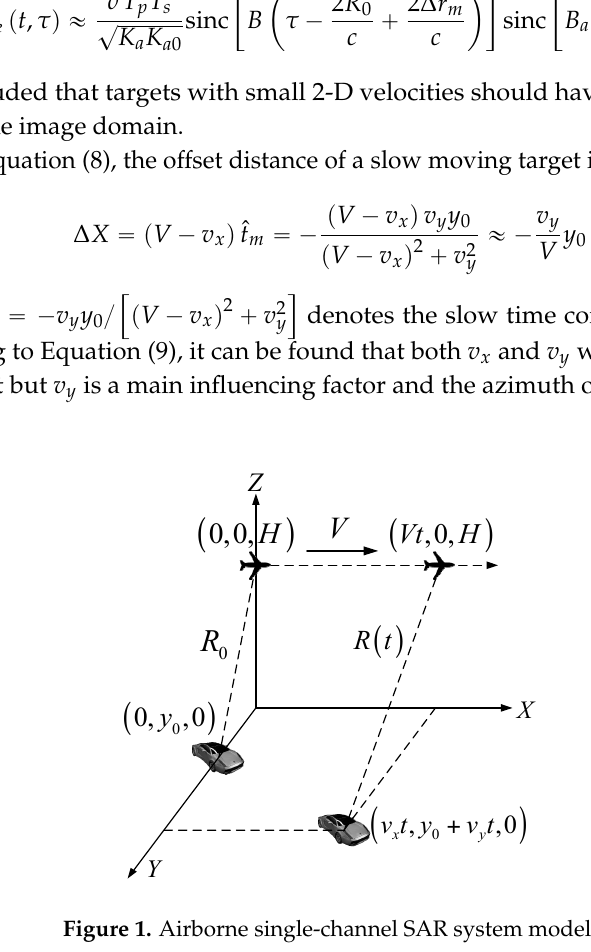
Figure 1. Airborne single-channel SAR system model.